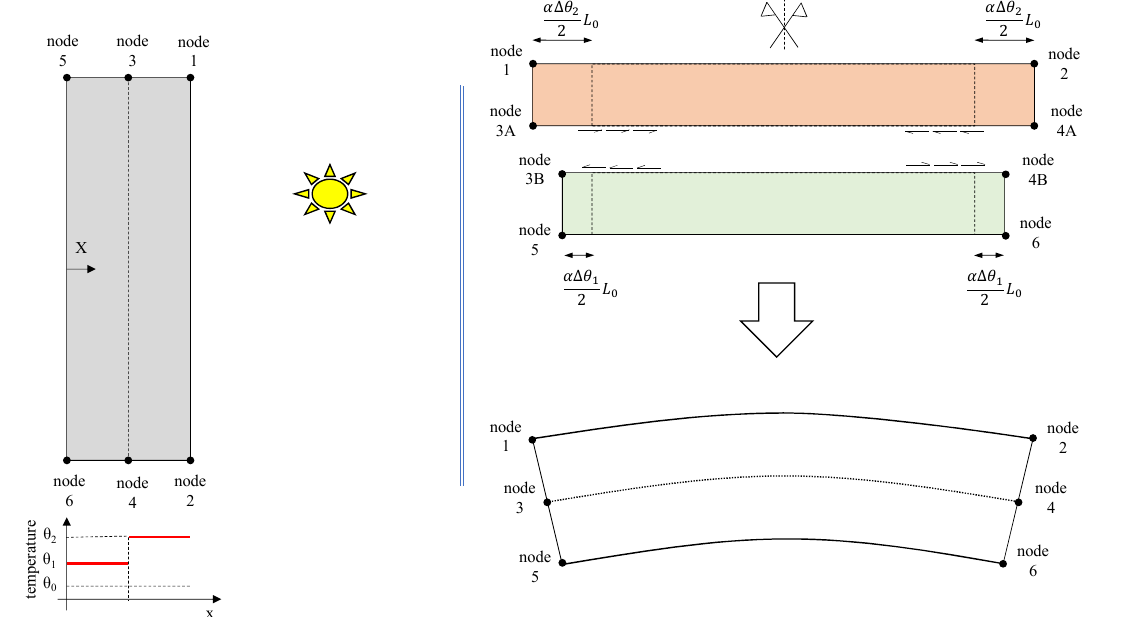
Figure 1. Idealization of the deformation due to thermal loading in continuum media.